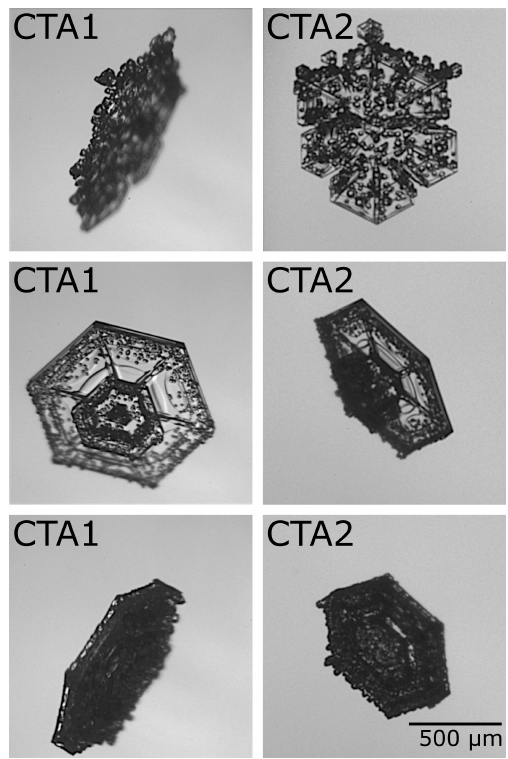
Figure 6. Three exemplary one-sided, moderately rimed particles shown from different perspectives by the two camera telescope as- semblies (CTA1 and CTA2). Note that the particle orientation in the stereo image does not reflect the actual orientation with respect to